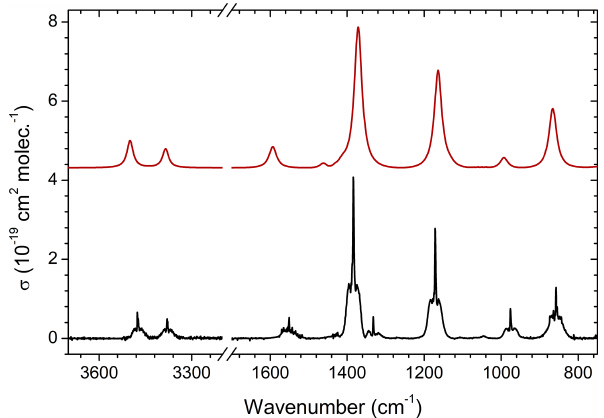
Figure 1. Comparison of the experimental infrared absorption spec- trum (black line) of MSAM ( ∼ 1 × 10 14 molec . cm − 3 ) and the cal- culated spectrum at B3LYP/aug-cc-pVTZ-pp levels of theory (red line). The cross sections ( σ ) are in base